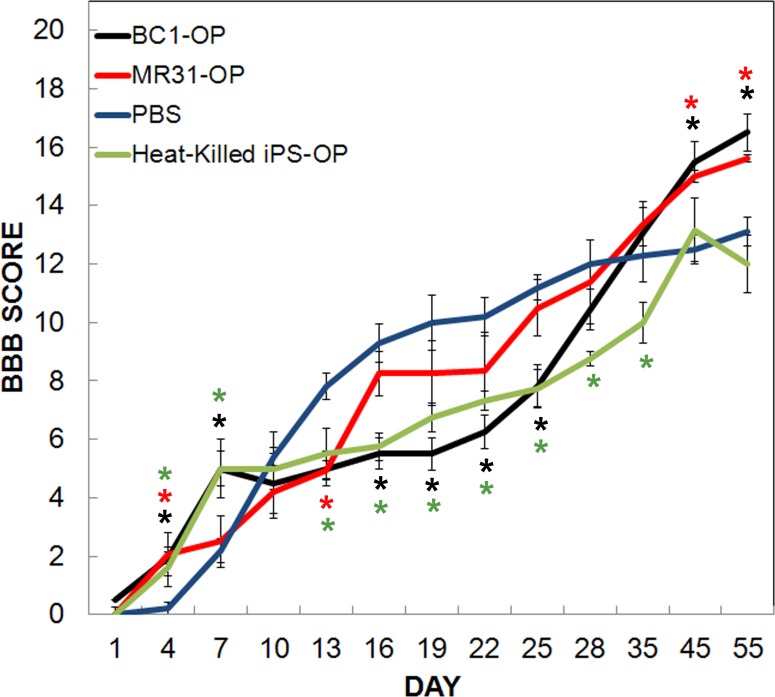
Behavioral assessment 8 weeks following moderate contusive injury (12.5mm) and cell transplantation in rats.The average of the Basso, Beattie, and Bresnahan (BBB) Locomotor Rating Scale (BBB SCORE) for left and right limb movement was evaluated for 55 days following spinal cord injury in rats injected with either PBS (blue), 500,000 heat-killed iPS-OP cells (green), live BC1-OP (black), or MR31-OP (red) cells 24 hrs after injury. Values in the graphs represent mean ± SEM of both left and right limbs as there were no significant differences in response between right and left limb scores. Statistical significance is denoted by a colored asterisk for each cell line with matched color compared to the PBS control group determined by one-way ANOVA followed by a two-way Student’s t-test assuming equal variances (P < 0.025).